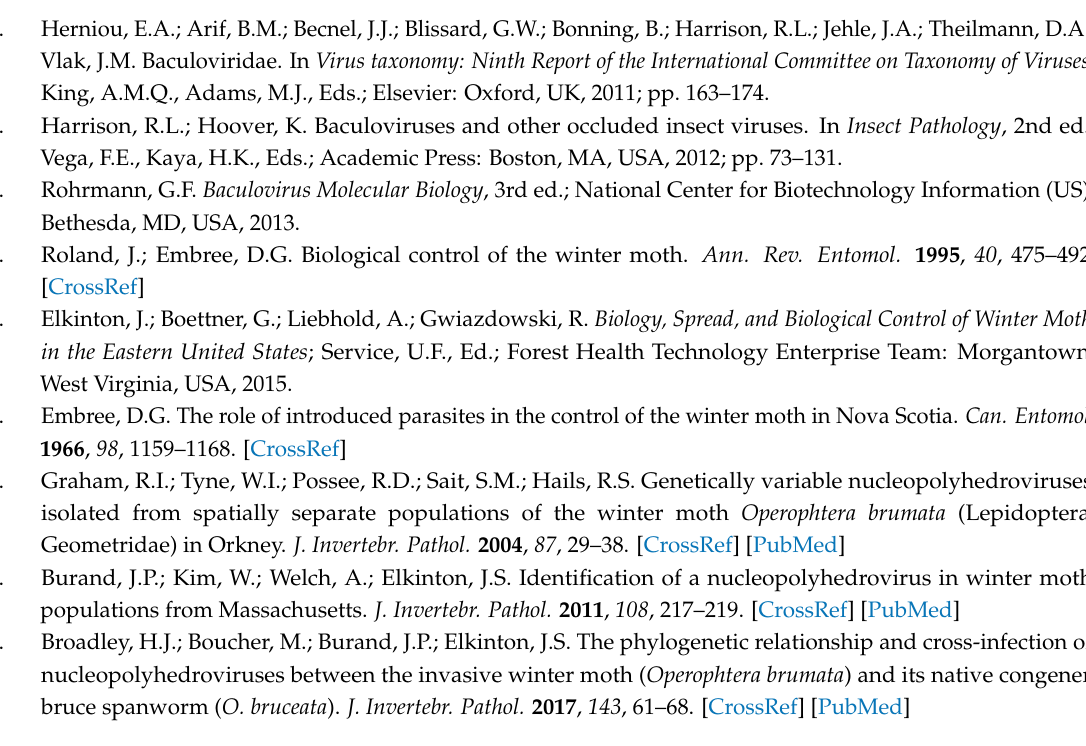
Figure S1: Frequencies of polymorphisms in the OpbuNPV-MA genome assembly; Table S1: Names, abbreviations, and GenBank accession numbers of taxa used in phylogenetic inference; Table S2: OpbuNPV-MA open reading frames (ORFs) and homologous repeat regions ( hr